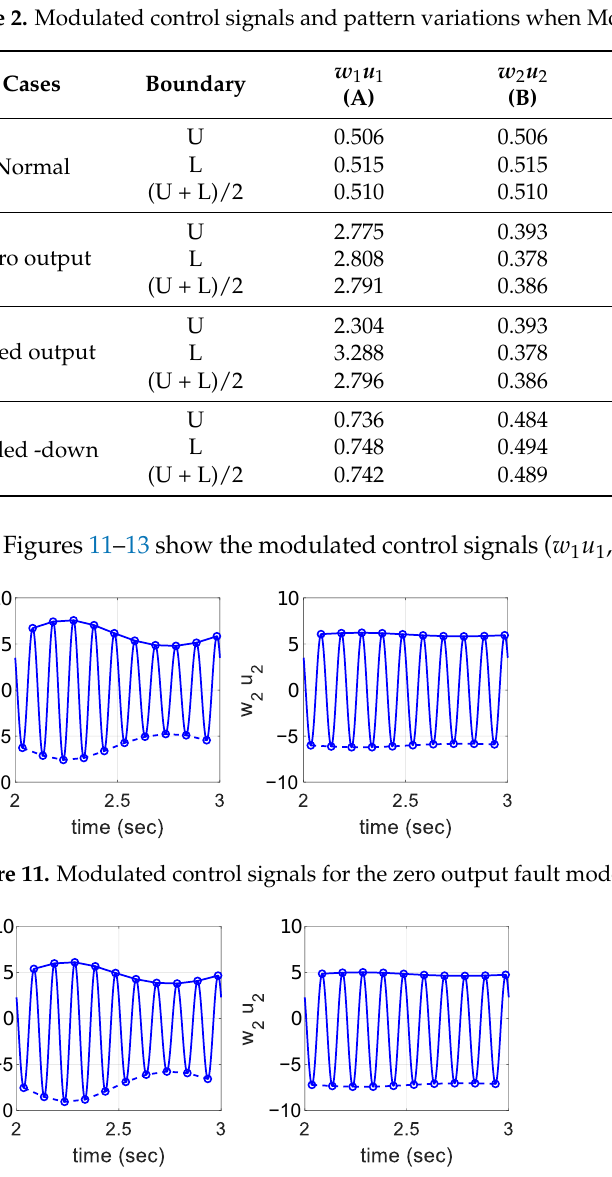
Figure 12. Modulated control signal for the fixed output fault mode (+500).